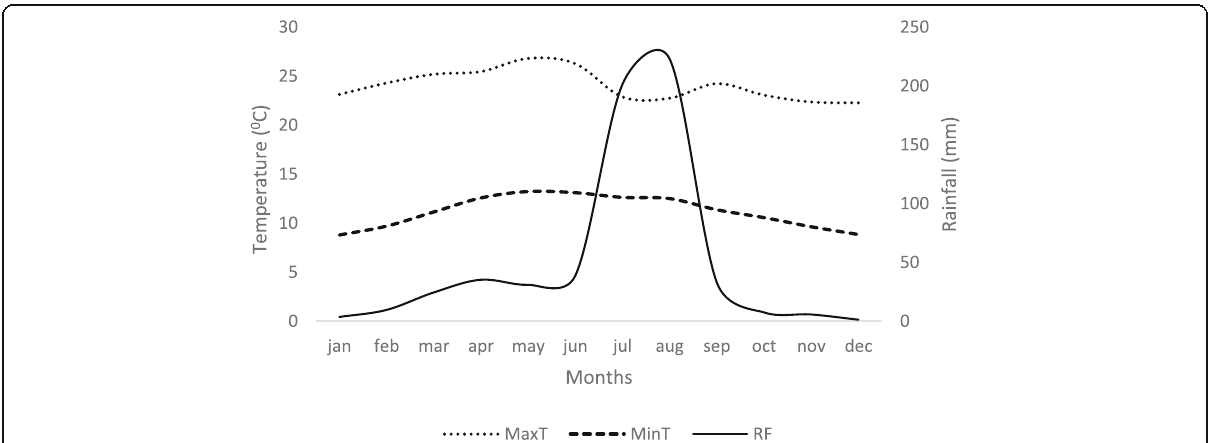
Fig. 1 Monthly average rainfall (RF), maximum temperature (MaxT) and minimum temperature (MinT) of the study area from 2002 to 2014 (EMA